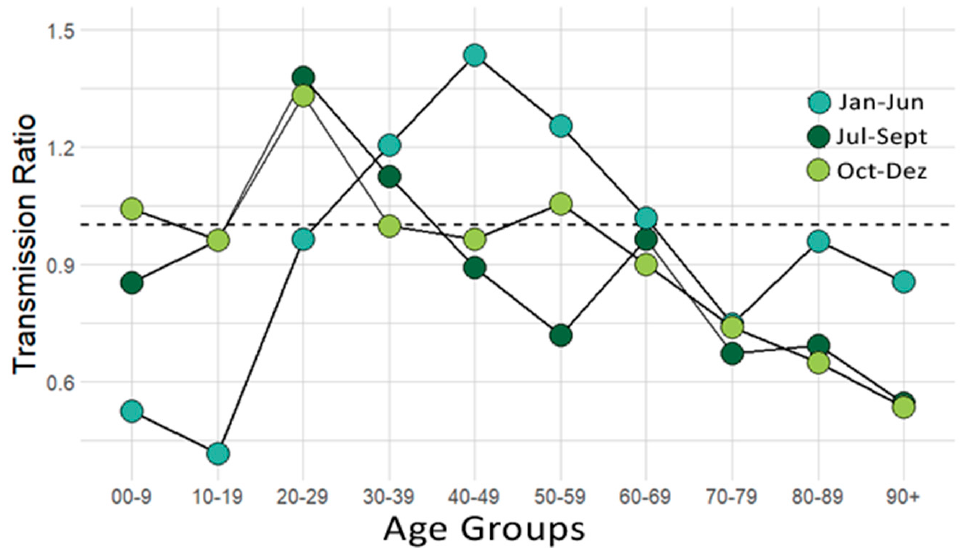
Figure 5. Transmission ratio regarding the municipality data for Jan–Jun, Jul–Sept and Oct–Dec time intervals.